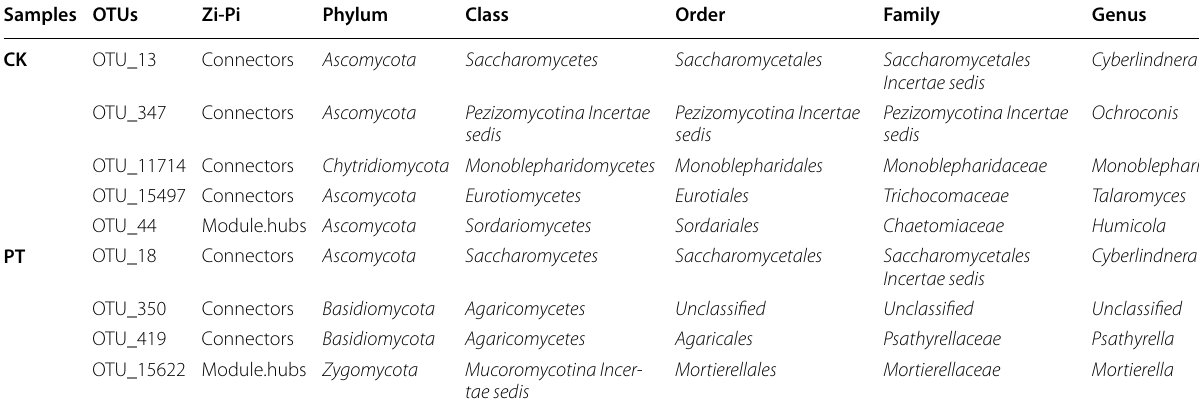
Table 5 Classification of the keystone fungal OTUs in Zi-Pi plot Samples OTUs